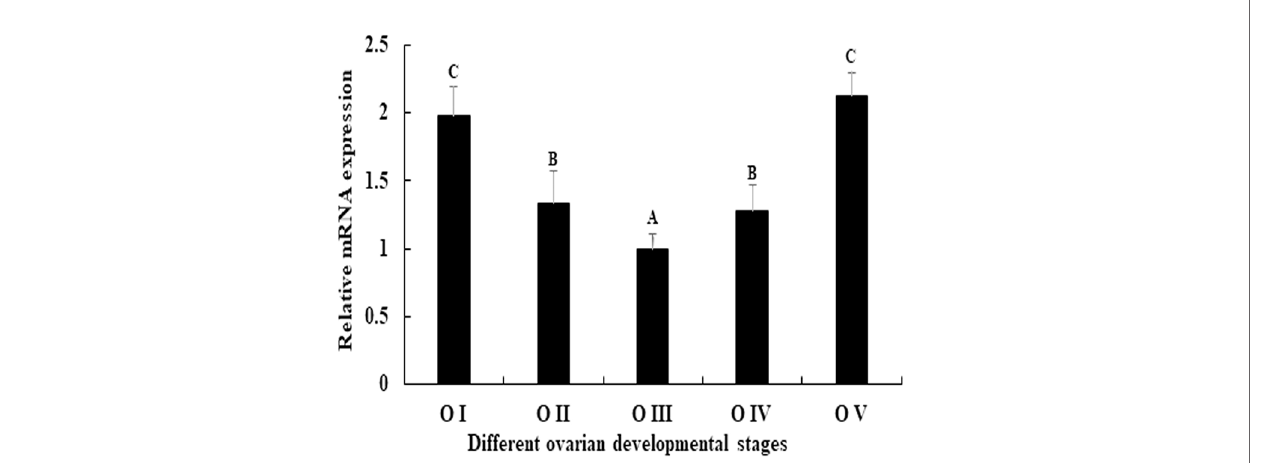
FIGURE 5 | Expression characterization of Mn-PDHE1 in different reproductive cycles of ovary. The amount of Mn-PDHE1 mRNA was normalized to the EIF transcript level. Data are shown as mean ±SD (standard deviation) of tissues from three separate individuals. Capital letters indicate expression difference between different samples.